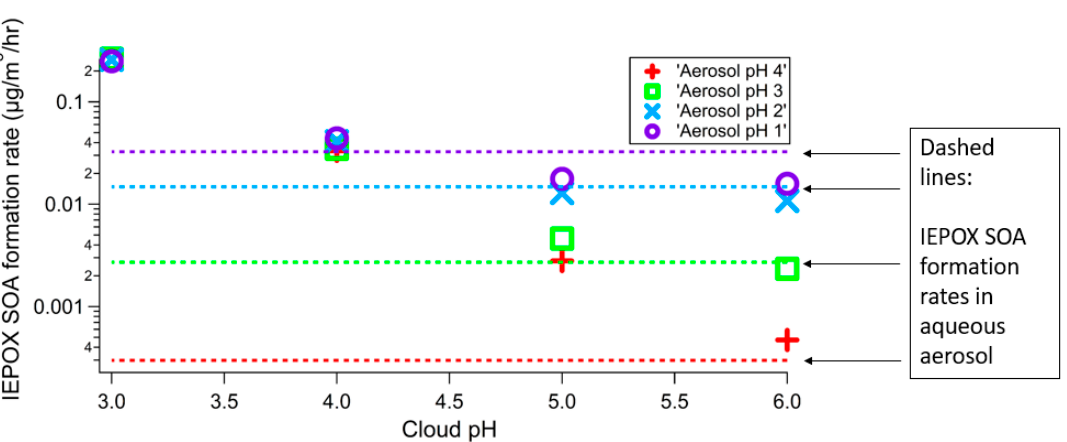
Figure 4. Comparison of IEPOX SOA formation rates in Simulation 1 for aerosol pH 1 to 4 and cloud pH 3 to 6. Rates are averaged over the entire six hours of the corresponding phase. Each individual point corresponds to the IEPOX SOA formation rate in cloudwater in the second half of the simulation with the pH of the aerosol in the first half of the simulation represented by the shape and color of the point as described in the legend. The same colors are used in the horizontal dashed lines corresponding to the formation in aqueous aerosols at the same pH in the first half of the simulation.